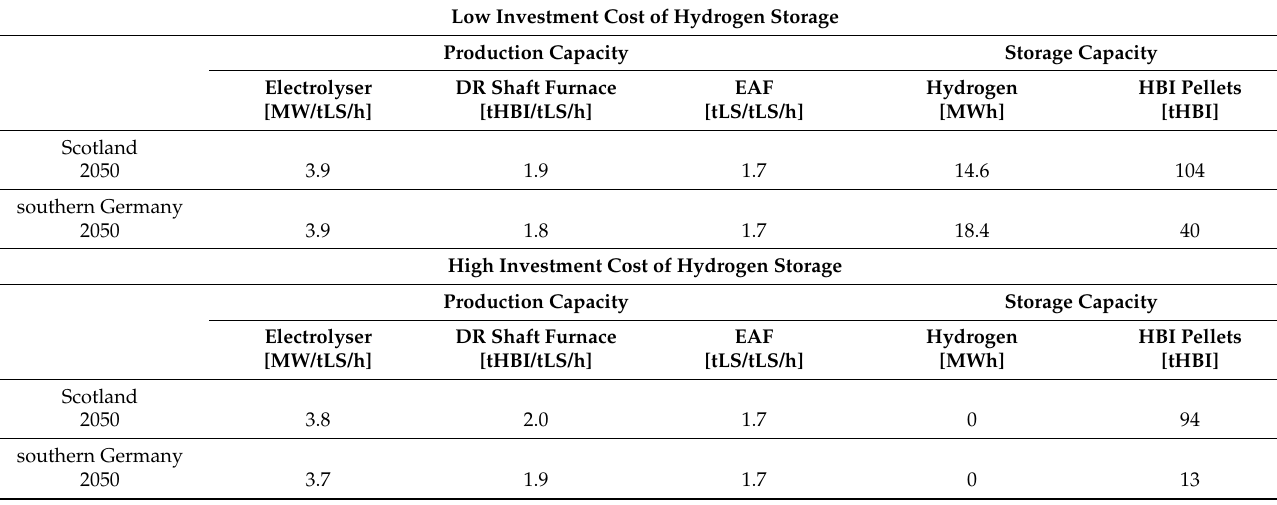
Table A3. The investment levels in steel production capacities and size of storages obtained from the modelling, for the electricity price profiles for the year 2050 and the two regions with high (0.0165 M € /MWh) and low (0.0055 M € /MWh) investment costs of hydrogen